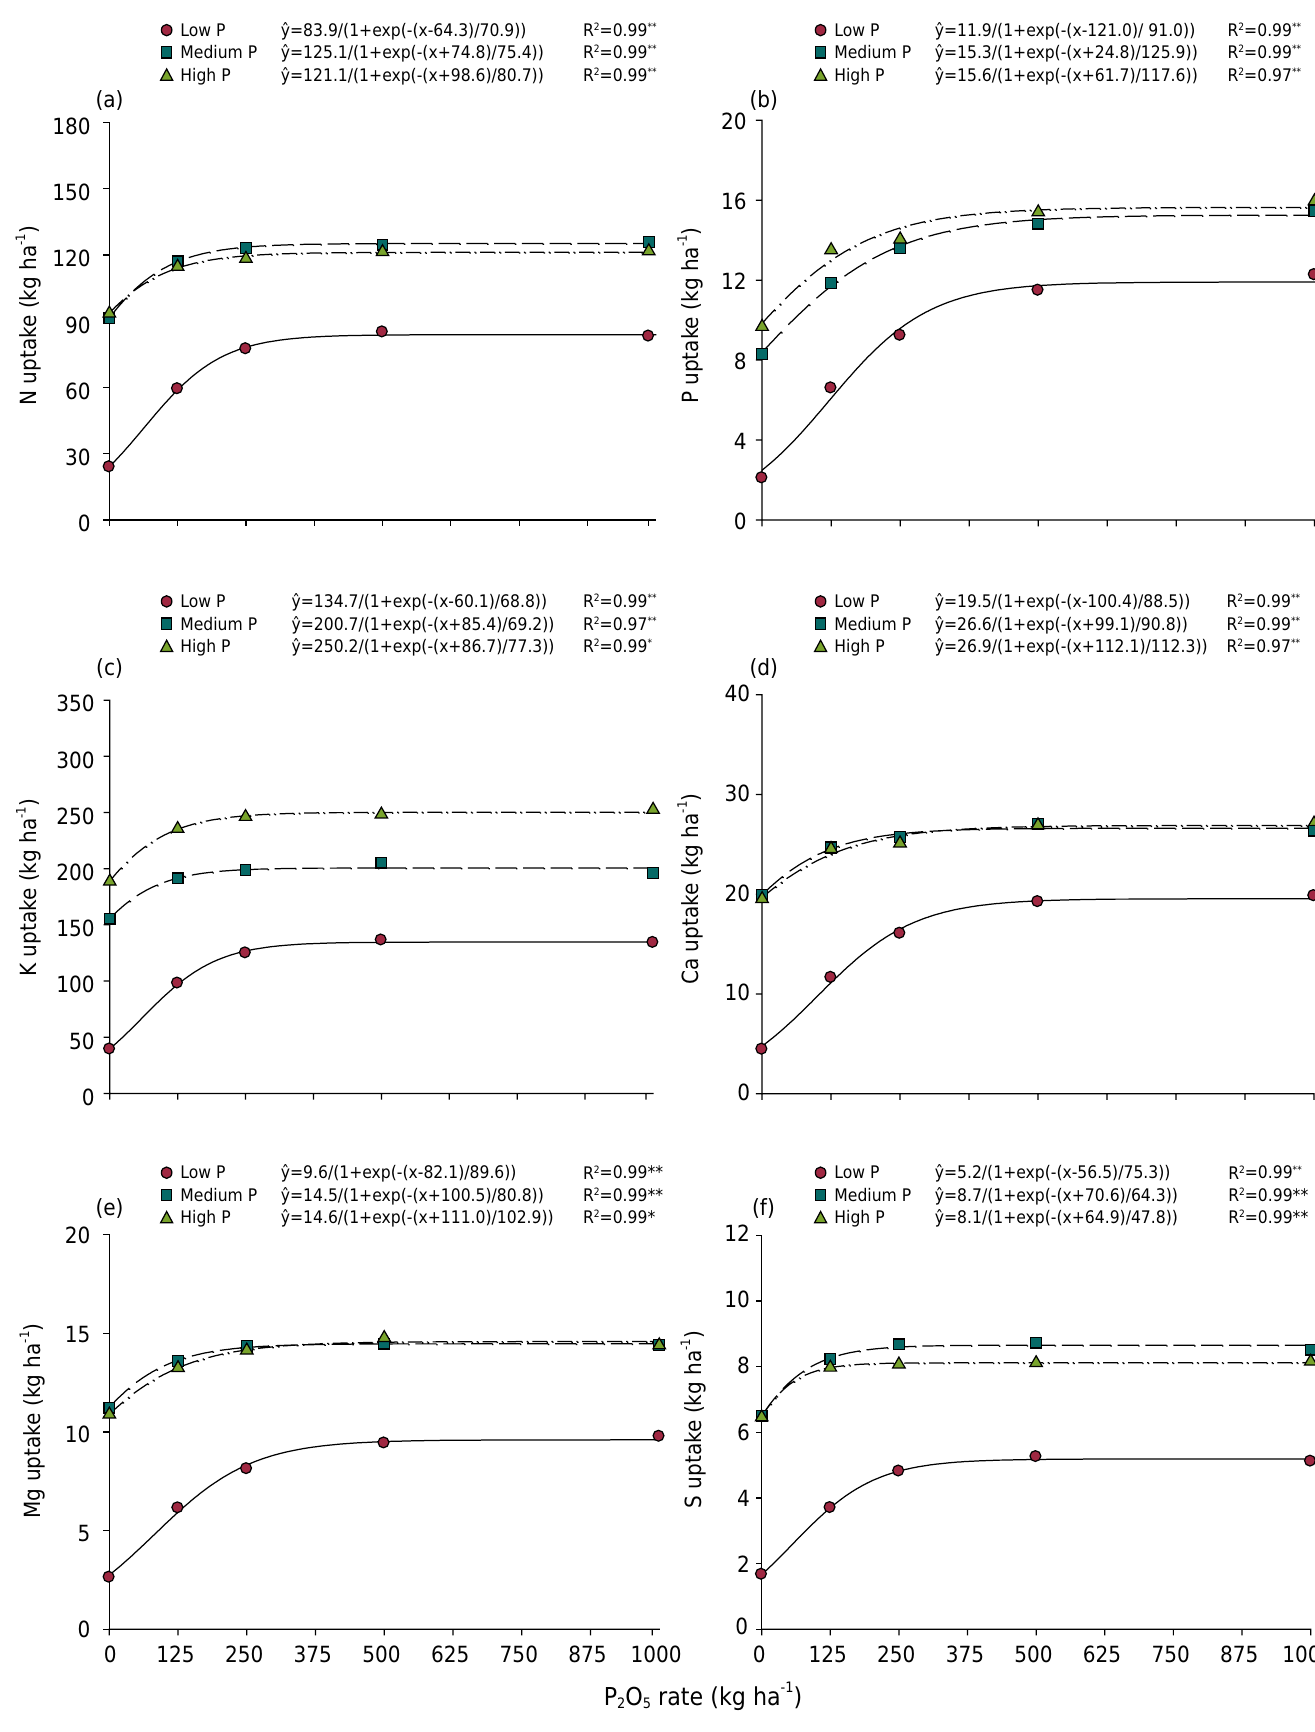
Figure 3. Uptake of N (a), P (b), K (c), Ca (d), Mg (e), and S (f) by potato plants as affected by rates of P applied in the planting furrow in soils with low, medium, and high P availability. Means of five cultivars. * and ** : significant at 5 and 1 % by the F